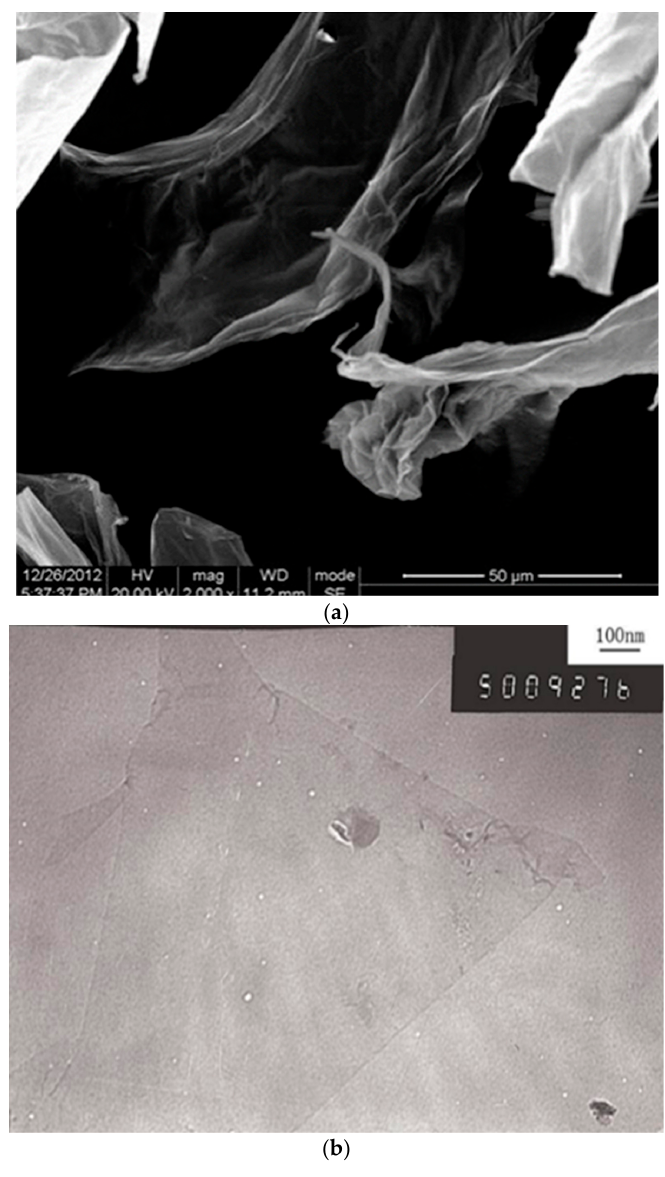
Figure 1. Images of GO nanosheets. ( a ) SEM image of multilayer GO. ( b ) TEM image of GO. Table 3. Ultra-high-performance concrete (UHPC) mixture proportions (kg / m 3 ) Table 2. The composition and dimensions of graphene oxide nanosheet.